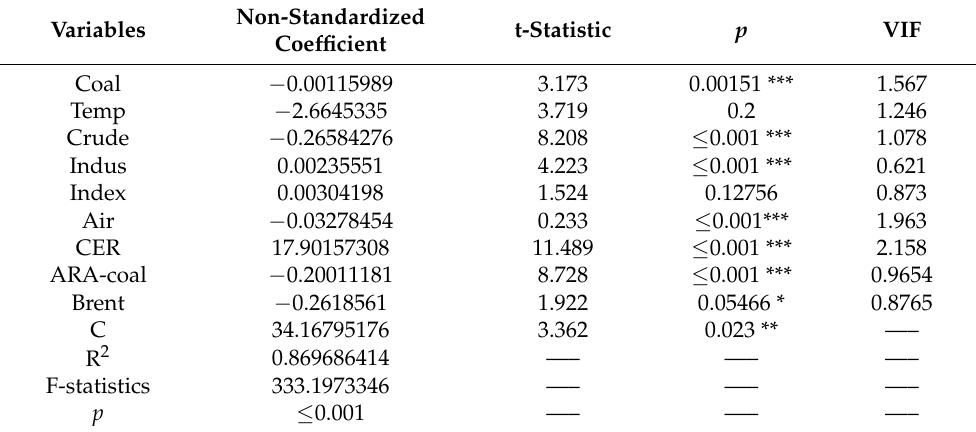
Table 8. Ridge regression estimators of variables (k =